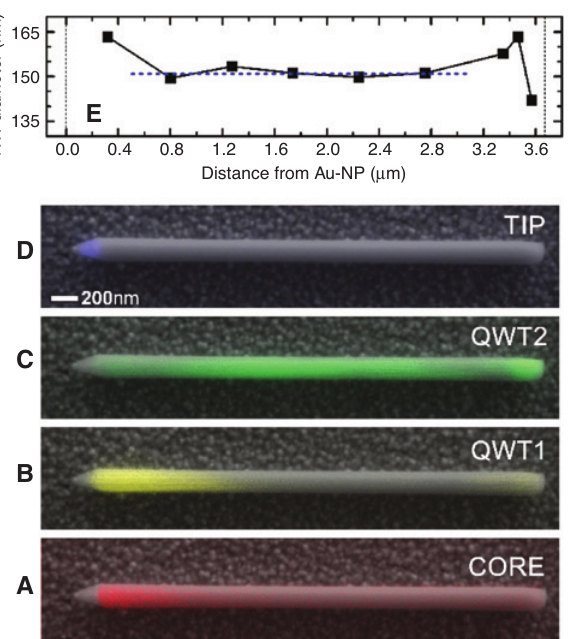
Figure 2: (A) Panchromatic CL image of the nanowire whose spectrum is reported in Figure 1A, (B–D) energy-selected CL images corresponding to the spectral intervals evidenced by the gray- hatched vertical regions in Figure 1A, (E) FE-SEM micrograph of the nanowire (the 200 nm marker in the micrograph holds also for CL images), and (F) values of nanowire diameters measured by FE-SEM at different positions along its length. The dashed horizontal line spans a relatively uniform diameter region corresponding to an average value of 177 nm.